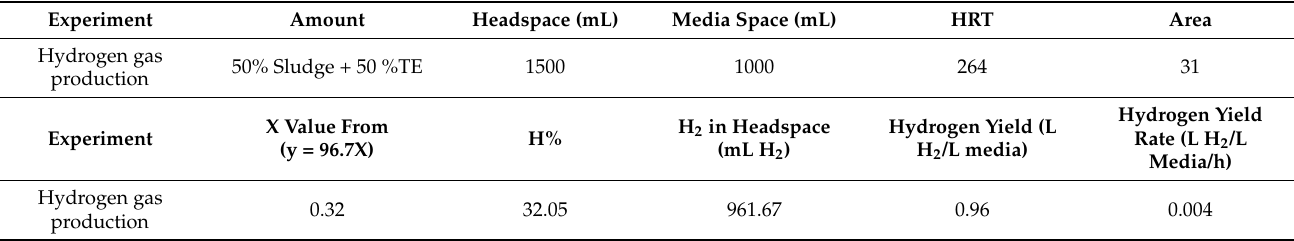
Table 6. Results of bio-hydrogen gas production.